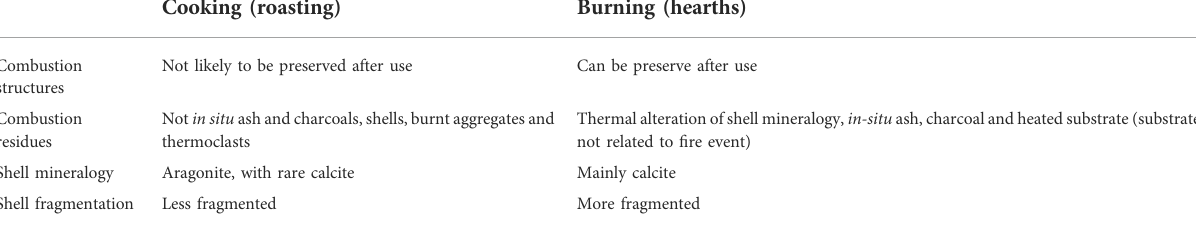
TABLE 1 Expectations on preserved traces of cooking shell fi sh versus burning